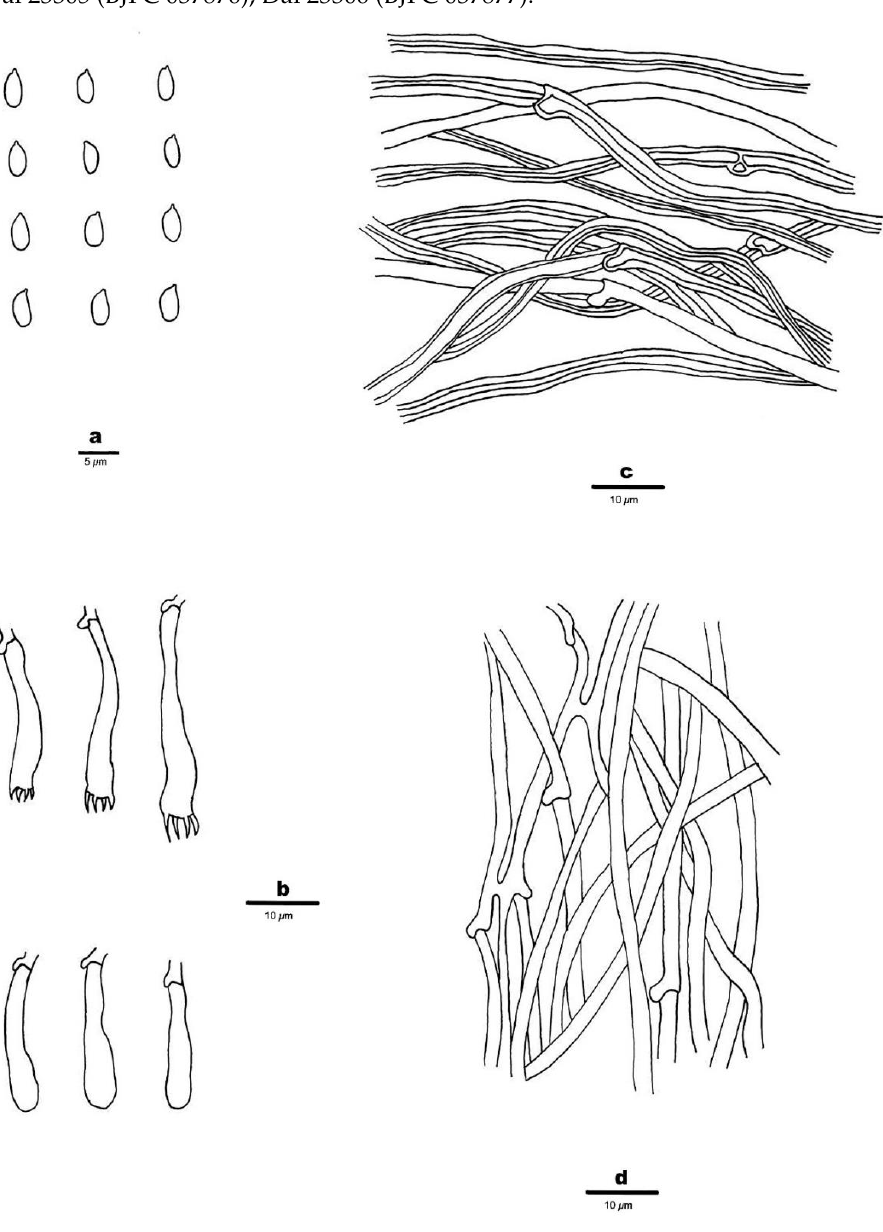
Figure 3. Microscopic structures of Hermanssonia fimbriata (Holotype, Dai 23266). ( a ) Basidiospores. ( b ) Basidia and basidioles. ( c ) Hyphae from subiculum. ( d ) Hyphae from subhymenium. Drawings by: Zhan-Bo Liu.